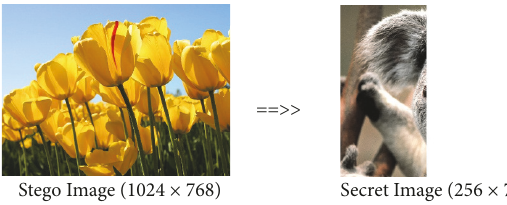
Figure 10: Decoding by previous